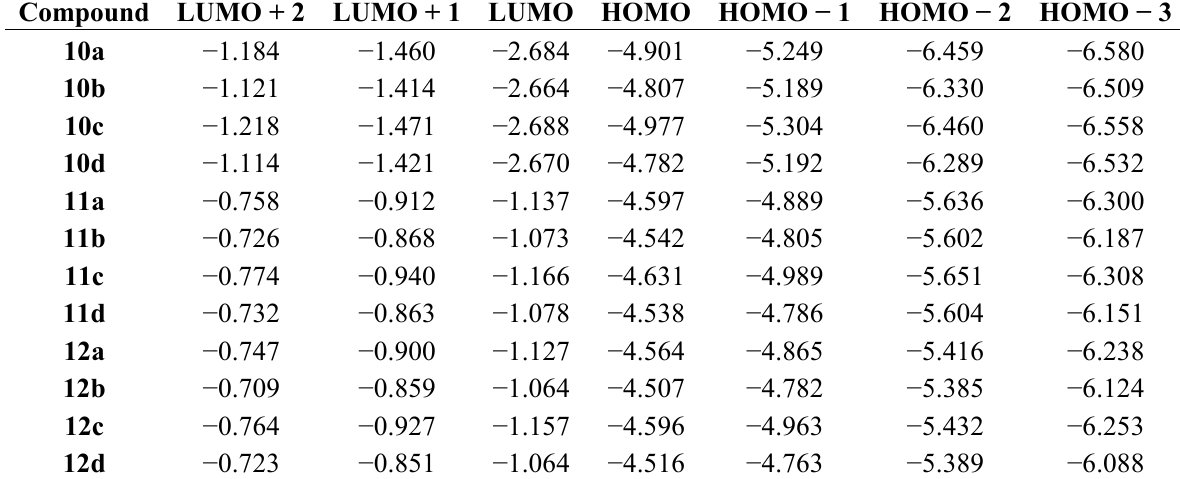
Table 2. Energy level (eV) of the molecular orbitals for products 10a – 12d